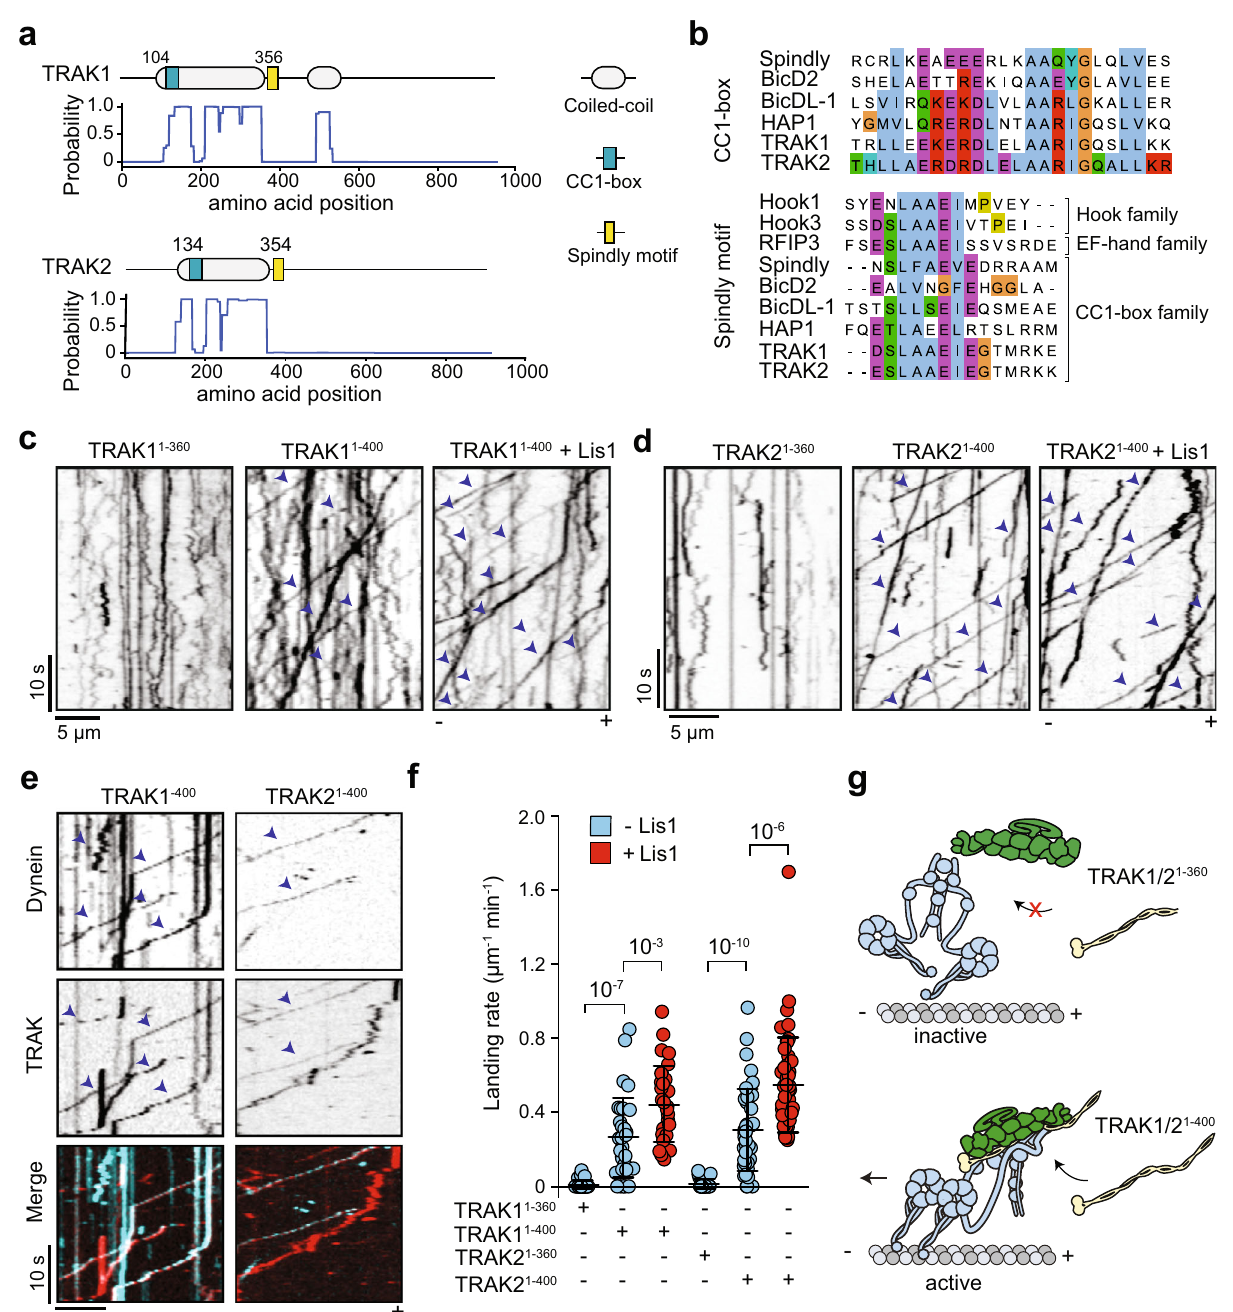
Fig. 1 | TRAK coiled-coil domains activate dynein-dynactin motility. a Domain organization and coiled-coil prediction score of human TRAK1 and TRAK2. b Sequence alignment shows the conserved CC1 box (top) and the Spindly motif (bottom) of TRAK1 and TRAK2 with other activating adaptors of human dynein-1. ThesequenceswerealignedusingtheClustalOmegaalgorithm. c , d Representative kymographs of TRAK1 ( c ) and TRAK2 ( d ) constructs labeled with the LD655 dye in the presence of unlabeled dynein/dynactin (DD) with or without 1 µ M Lis1. Arrow- headshighlightprocessivemotility. e RepresentativekymographsofLD655-dynein